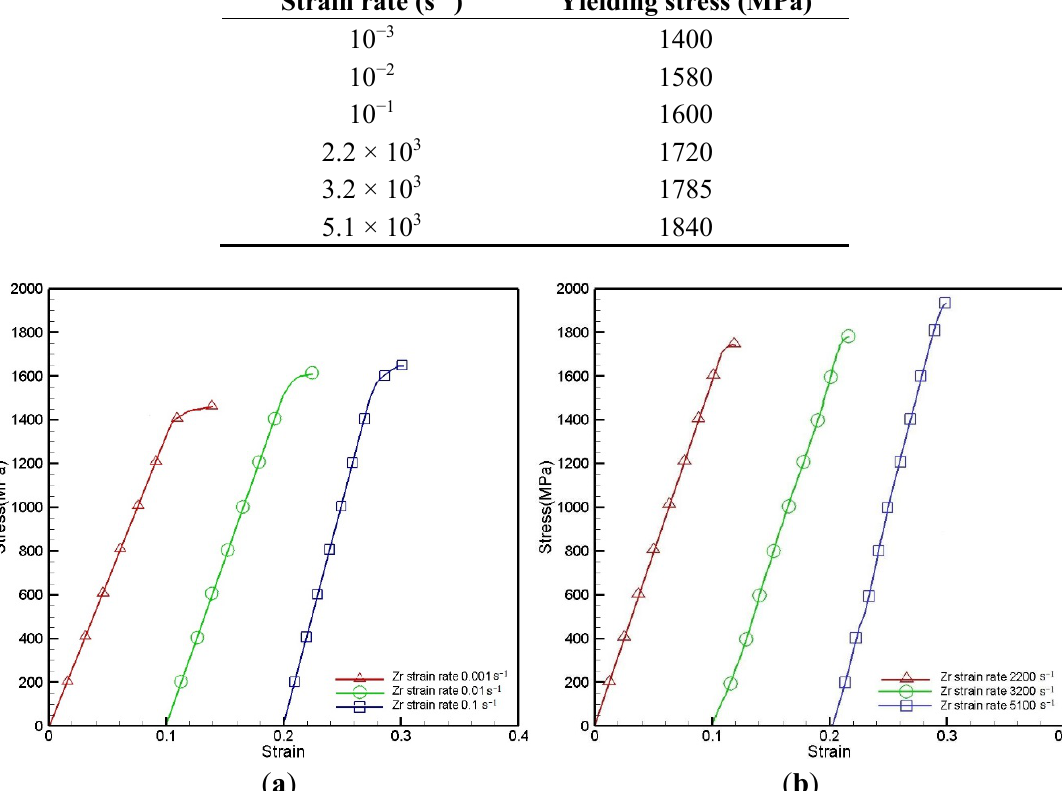
Figure 3. True stress-strain curves of Zr-based metallic glass deformed at strain rates of ( a ) 10 − 3 , 10 − 2 and 10 − 1 s − 1 ; ( b ) 2.2 × 10 3 , 3.2 × 10 3 and 5.1 × 10 3 s − 1